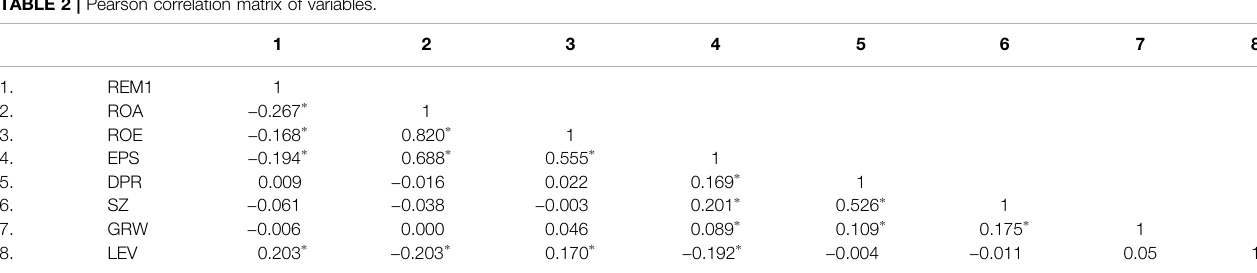
TABLE 2 | Pearson correlation matrix of